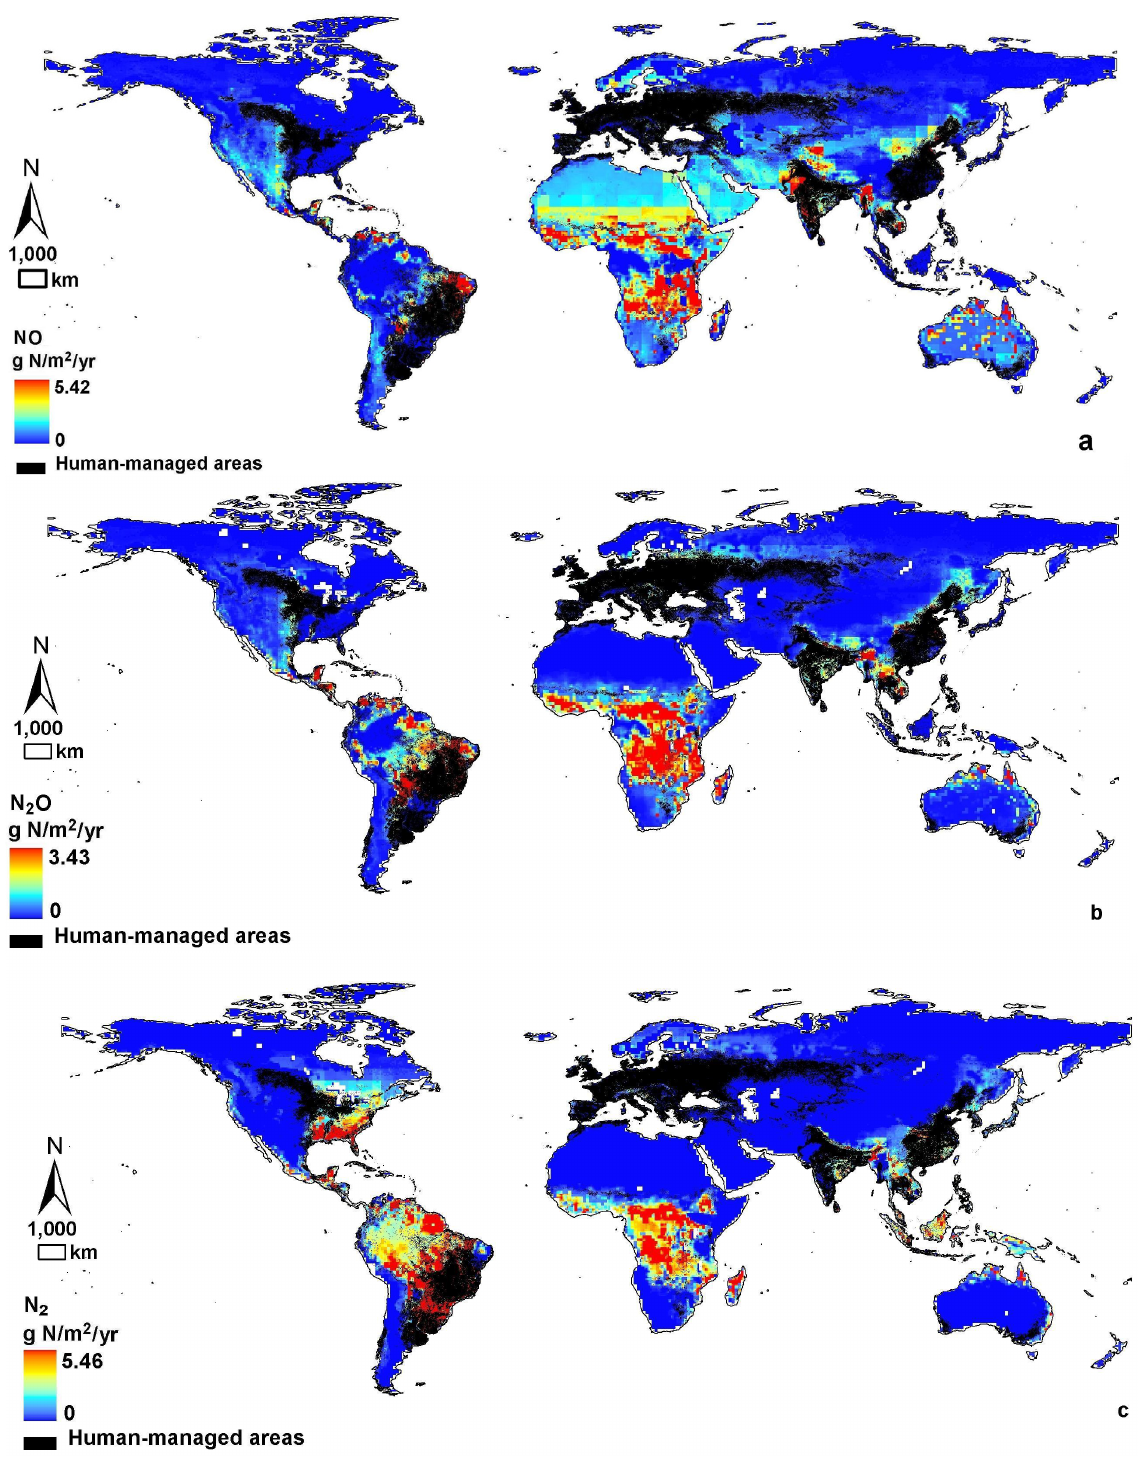
Fig. 8. Global patterns of NO (a) , N 2 O (b) , and N 2 (c) from unfertilized